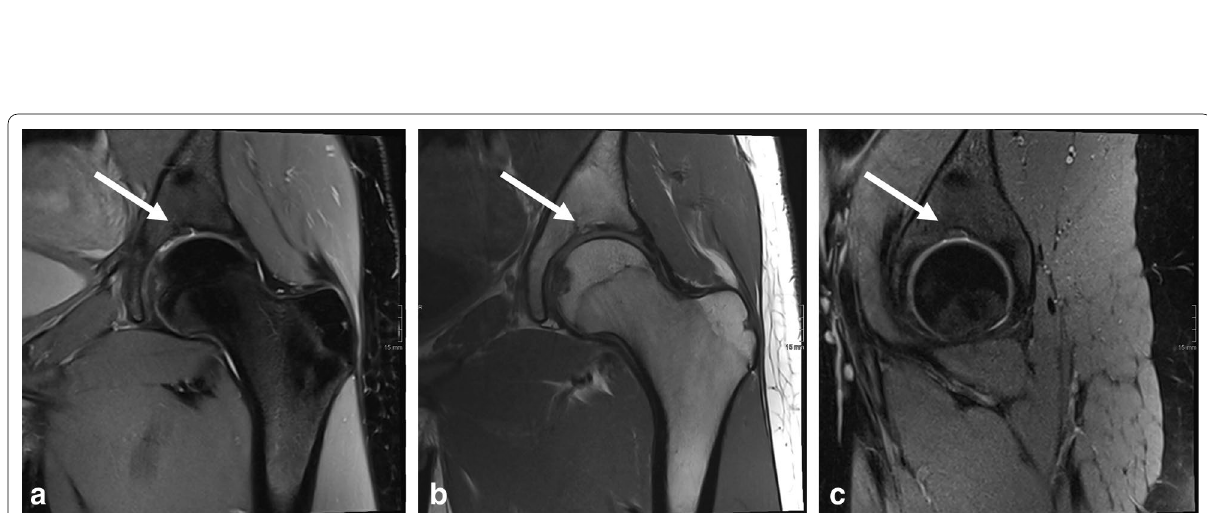
Fig. 5. 13-years-old female participant with SAF which is partly cartilage filled (white arrow). This example may represent a transitional state from SAF type 1 to SAF type 2: Proton density (PD) weighted ( a ), T1 weighted coronal ( b ) and PD weighted sagittal ( c )